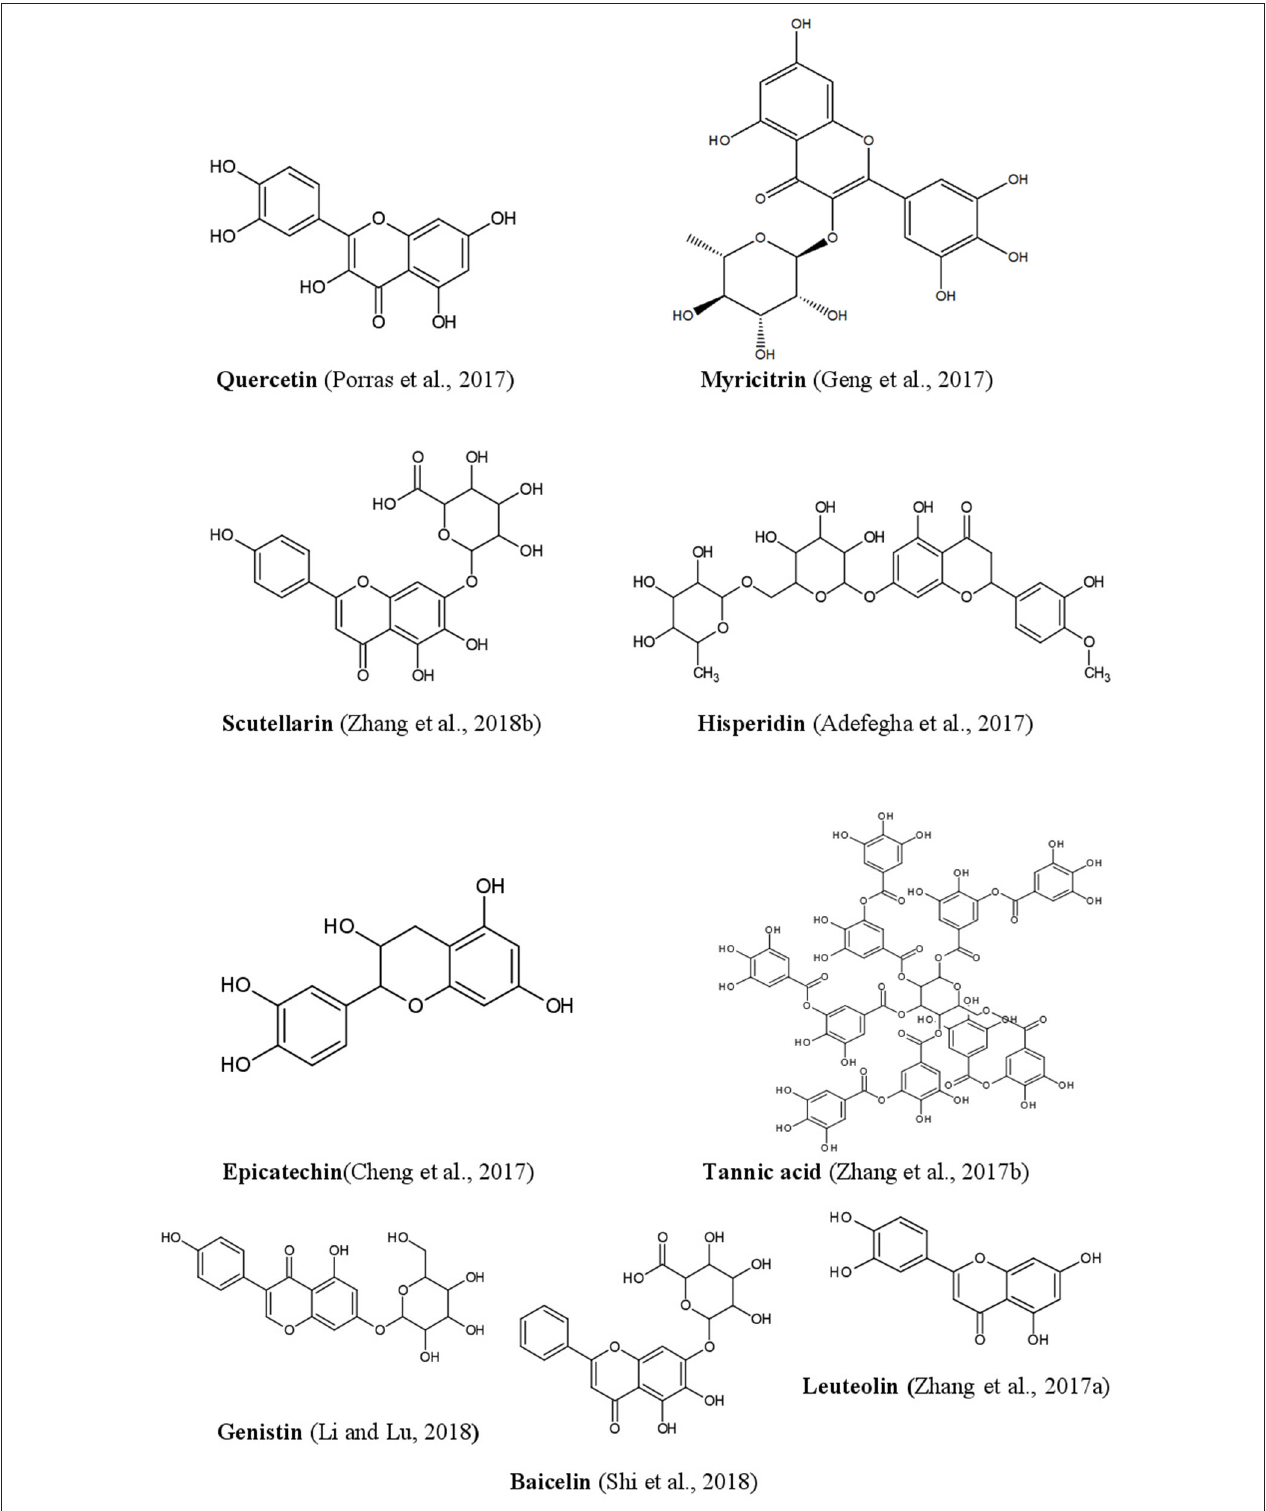
FIGURE 5 | Structures of some bioactive phenolics acting as hepatoprotective compounds.